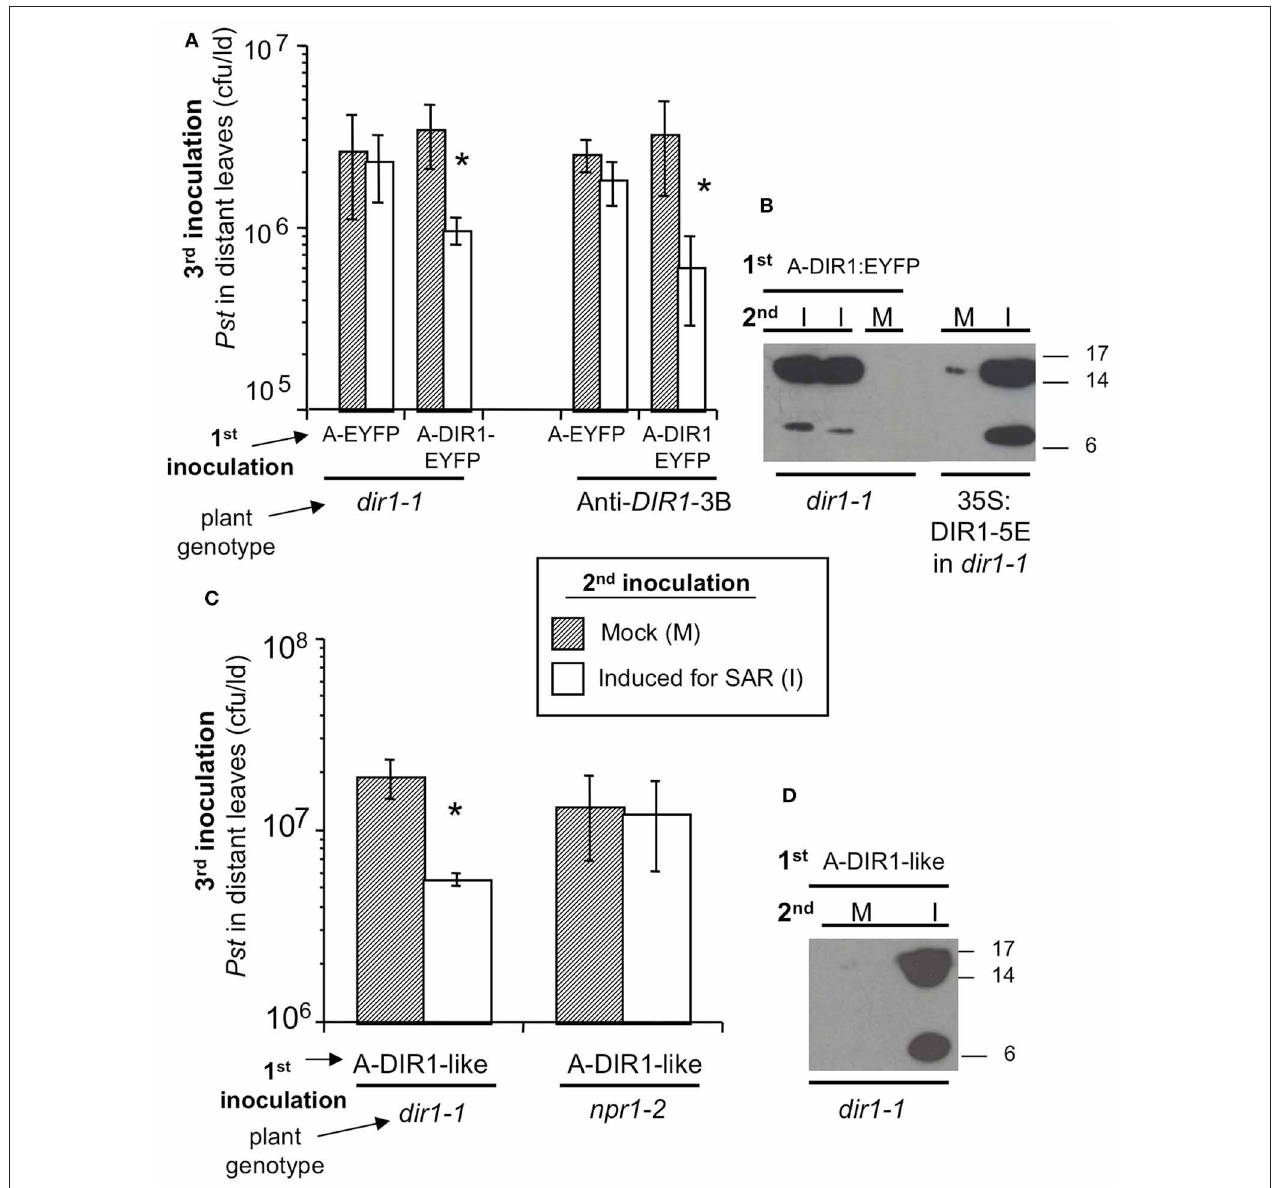
FIGURE 5 | Transient expression of DIR1 and DIR1-like in one leaf rescues the SAR defect in dir1-1 . (A) dir1-1 and 35S:antisense DIR1 -3B (Anti-DIR1-3B) plants were subjected to the Agro-SAR assay. 1st inoculation in 2 leaves with either Agrobacterium (Agro) containing EYFP or DIR1-EYFP, then a 2nd inoculation 4 days later in the same leaves with either 10mM MgCl 2 (Mock) or 10 6 cfu ml − 1 Pst (avrRpt2) (Induced for SAR). Two days later, one set of plants received a 3rd inoculation with virulent Pst (10 5 cfu ml − 1 ) in distant leaves and Pst levels were measured 3dpi. Asterisks ( ∗ ) denote a significant difference (student’s t -test) in Pst levels between mock-inoculated and SAR-induced plants. (B) Petiole exudates were collected (20–44hpi) from